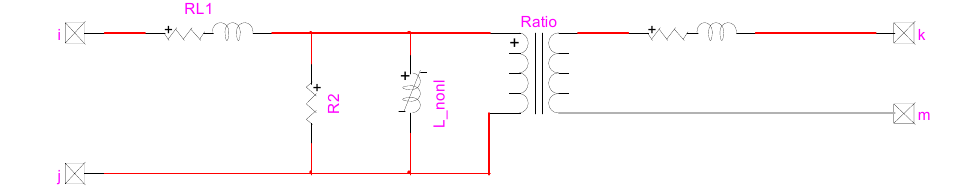
Figure 4. Basic building block for each phase of the transformer, EMTP-RV model.